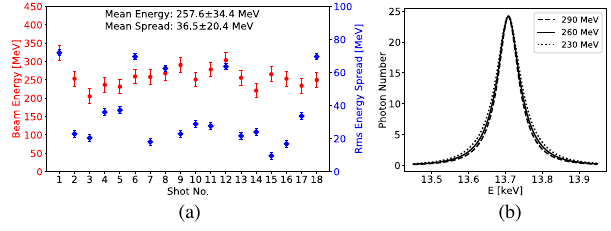
FIG. 3. (a) Shot-to-shot variations of beam energy and energy spread. (b) Simulated PXR line for different beam energies of interest (bunch charge 40